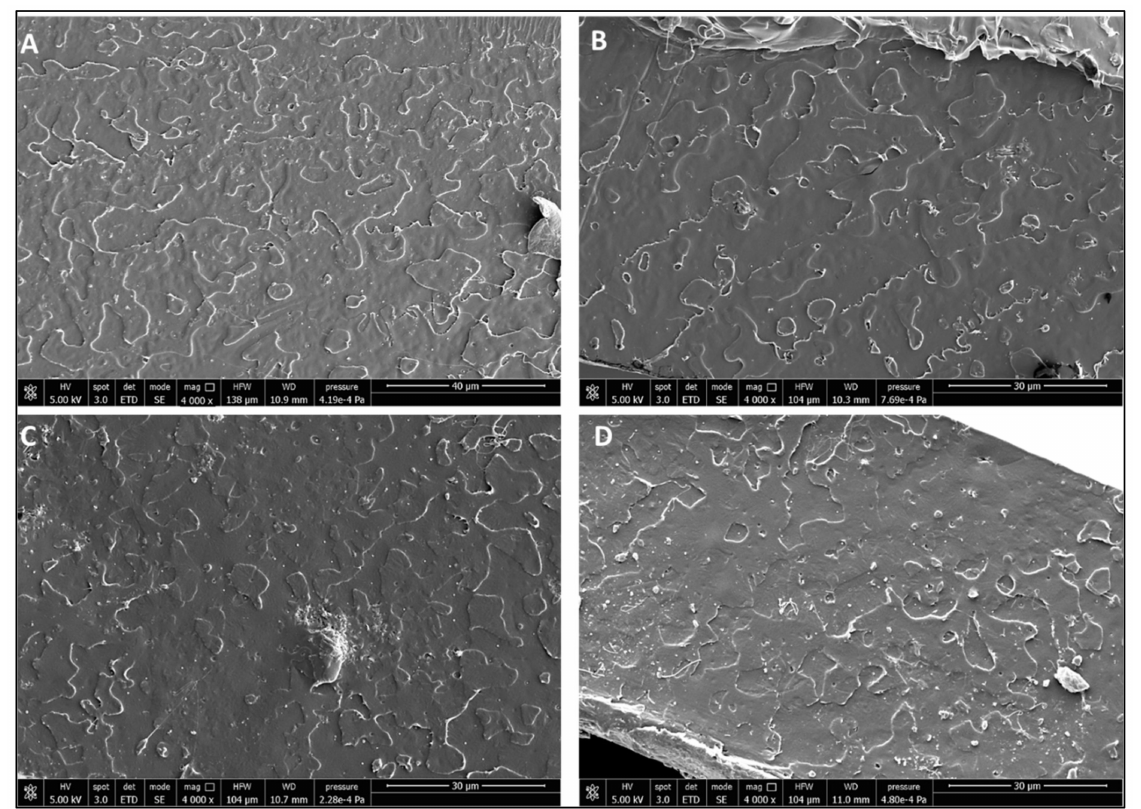
Figure 8. SEM micrographs of PLA_PEG_15_EX ( A ), PLA_OLA_15_CE ( B ), PLA_PEG_15_EX ( C ), and PLA_OLA_15_CE ( D ) at a magnification of 4000 ×